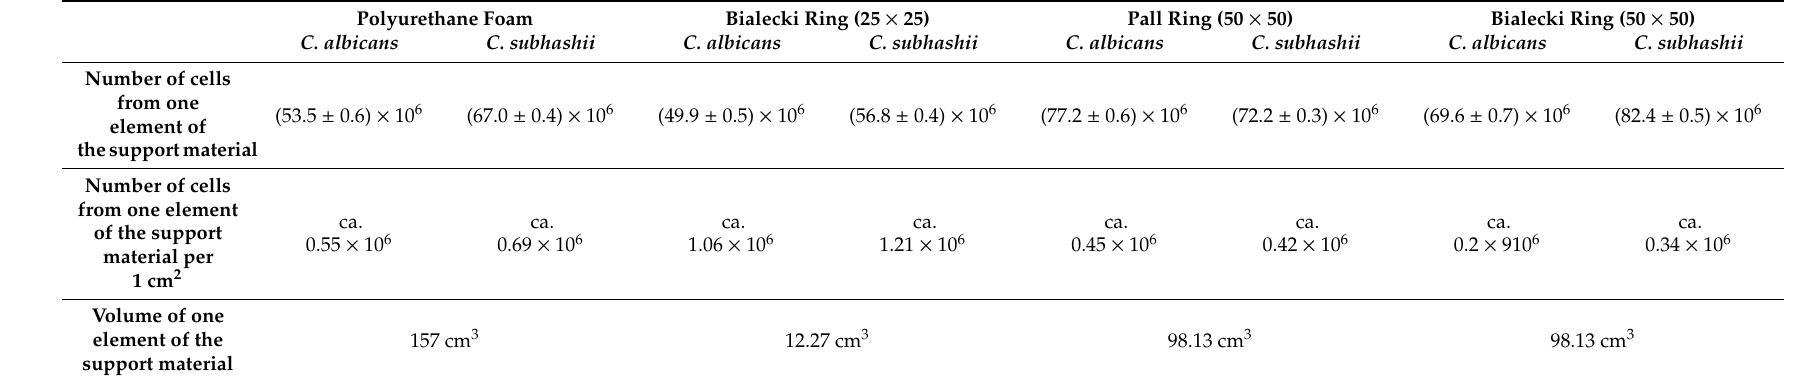
Table 4. Cytometric count of selected fungal cells after detaching them from the support